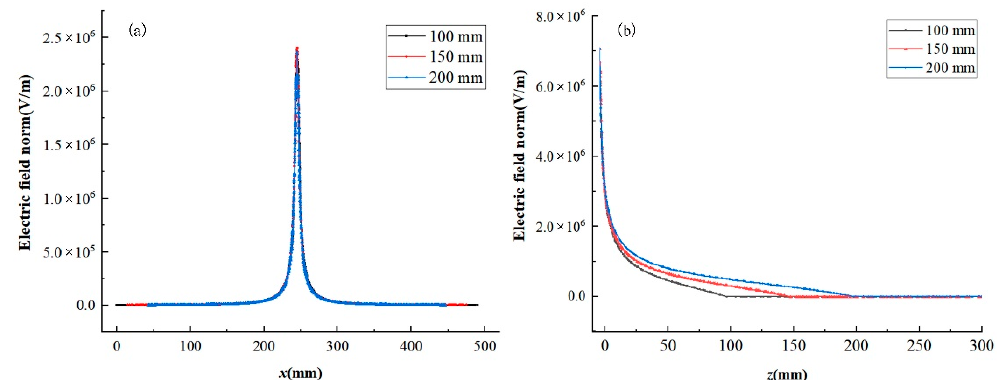
Figure 8. Electric field intensity of electrospinning setups for different receiving distances with a spinning voltage of 20 kV; ( a ) electric field intensity along the x -axis at 2 mm below the needles and ( b ) electric field intensity along the z -axis.